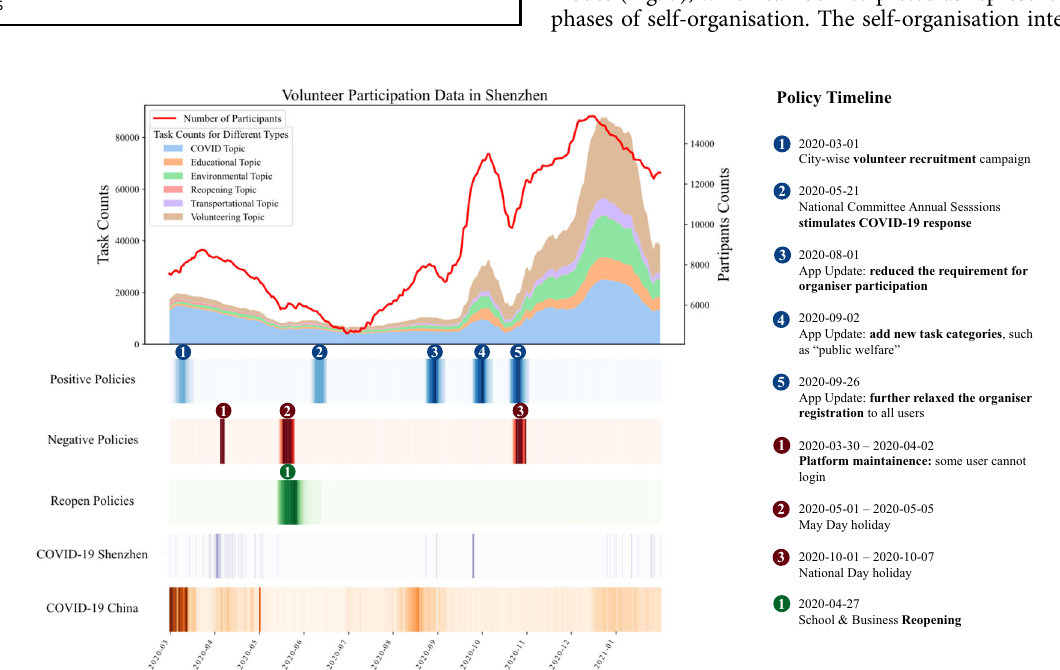
Fig. 4 Overview of the volunteer data used in this study. Left top: The Stacked area plot shows the average number of volunteer tasks in each of the six categories (in a 2-week window) over the entire duration of the study; Red line plot shows the total number of volunteer participants per day; Left Bottom: External information used in the causality analysis. The colour shading indicates the stringency of a policy group or the number of COVID-19 cases. Details on the data can be found in the “ Methods ” section. Right: Timelines for positive, negative, and reopening